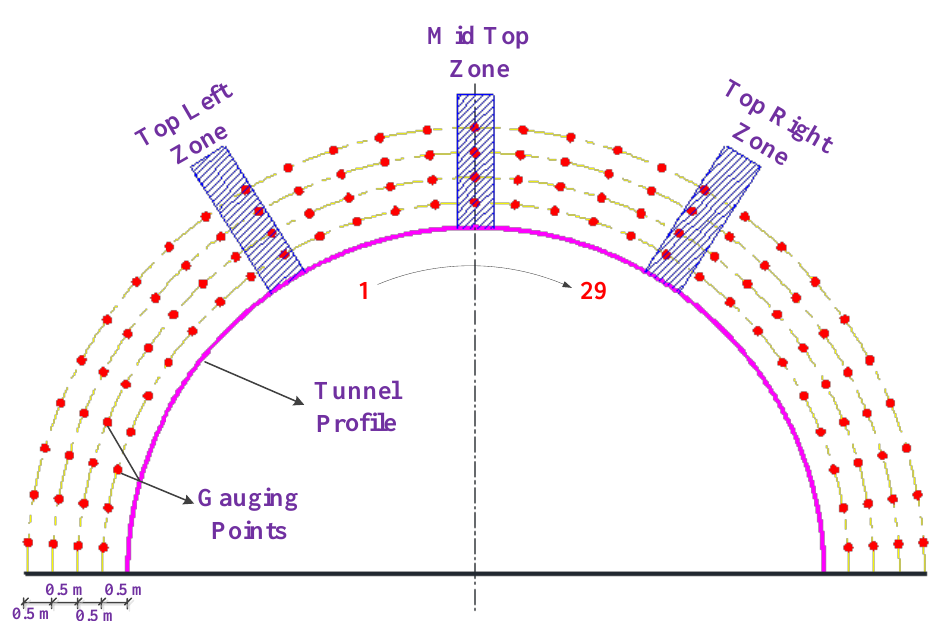
Figure 16. Positions of gauging zones and gauging points.